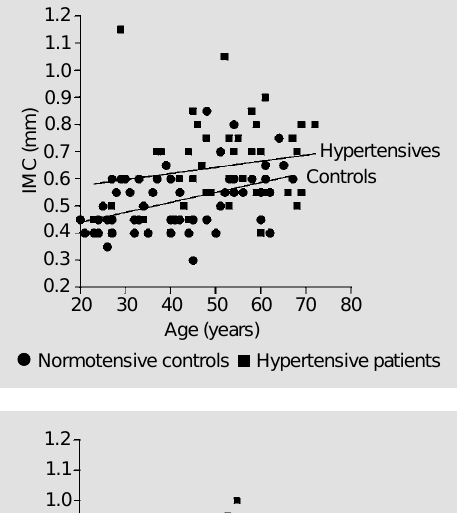
Figure 3 - Correlation between common carotid intima-media complex (IMC) and 24-h SBP for normotensive controls (N = 63) and hypertensive patients (N = 52). The equation for IMC-nor-